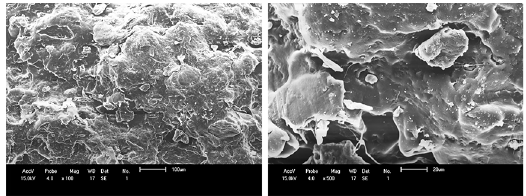
Figure 14: SEM image of fractured surface of PCL/cotton nanolinter (5%). (Scale bar: 100 μm and 20 μm). were obtained. Nevertheless, increases of 6% and 16% were observed in elastic modulus of PCL/cotton linter (3%) and PCL/cotton linter (5%) compounds, respectively, whereas no change was verified in flexural strength and maximum deformation for PCL compounds with cotton linter. The reduction in the Elastic Modulus, Flexural Strength and Impact Strength (see Figure 8) of nanolinter compounds compared with conventional cotton linter compounds may be explained in part by possible increase of tension concentration regions originated the nanoparticles as well as by aggregation mechanisms. Flexion experiments may be used to define bending tolerance of polymer products; for this specific use compounds with cotton linter should be chosen instead of cotton nanolinter